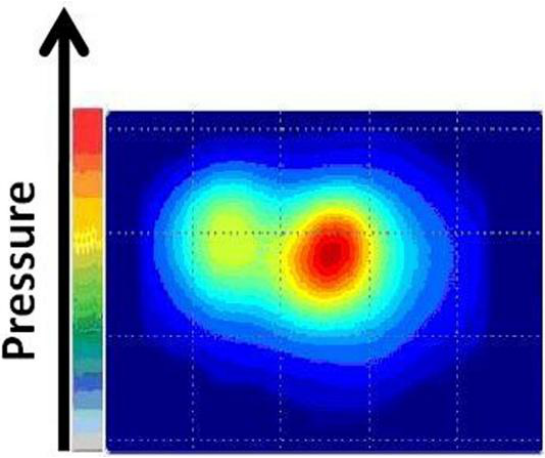
FIGURE 9. Graphic output of pressure measured as a response to predetermined deformation in a testis model. Colors of testicular areas on the floor plan of the model represent pressure values. The color scale on the left shows the correspondence of colors and pressure. The gray represents the minimum value of 0.0068 kg/cm 2 and the red color represents the maximum value of 0.07 kg/cm 2 . Warmer colors represent areas of high pressure, while cooler colors represent areas of lower pressure. Pressure values reflect the rigidity of the phantom in the respective areas of the